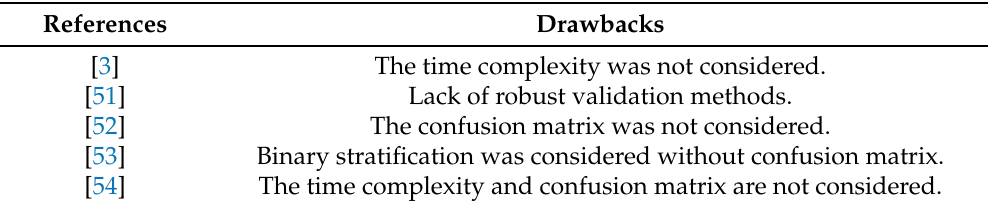
Table 3. The disadvantages of existing